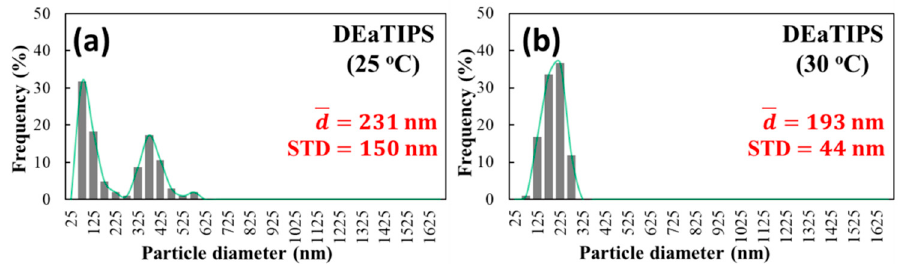
Figure 10. Particle size distribution of DEaTIPS samples at different evaporation temperature: ( a ) 25 °C and ( b ) 30 °C.